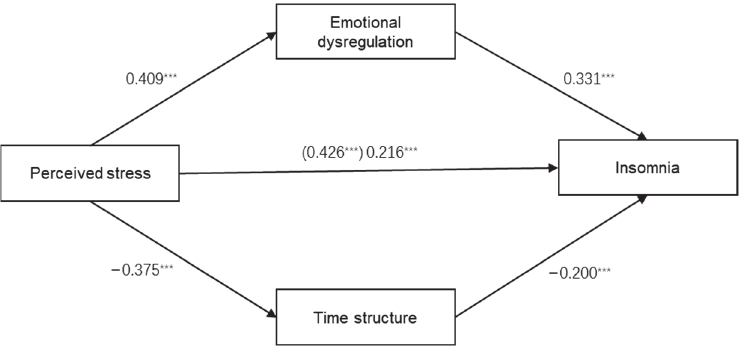
Figure 1. The mediation model for perceived stress, emotional dysregulation, time structure, and insomnia (N = 511, *** p < 0.001).